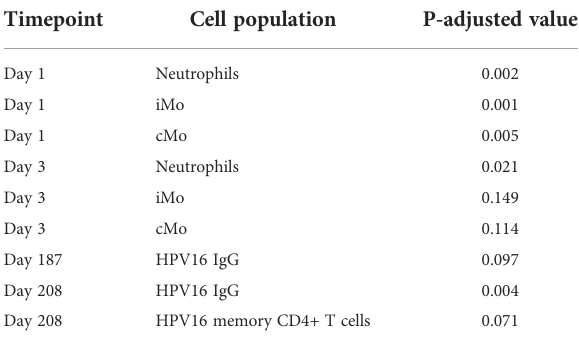
TABLE 1 Cell populations showing signi fi cant differences in cell numbers between bivalent and nonavalent vaccine recipients, strati fi ed per